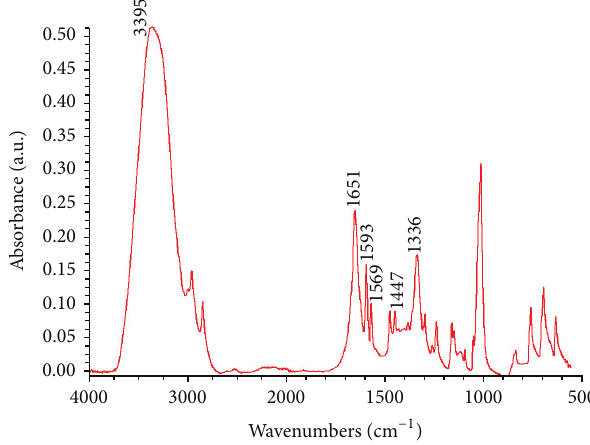
Figure 5: Infrared spectrum (4000–500 cm −1 ) of ASA:NC via synthetic Route 1 (water synthesis).